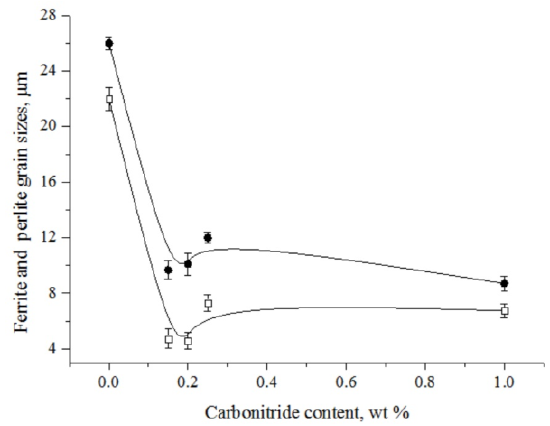
Figure 3. Ferrite (●) and pearlite (□) grain size as a function of the content of titanium carbonitride nanoparticles in coatings.